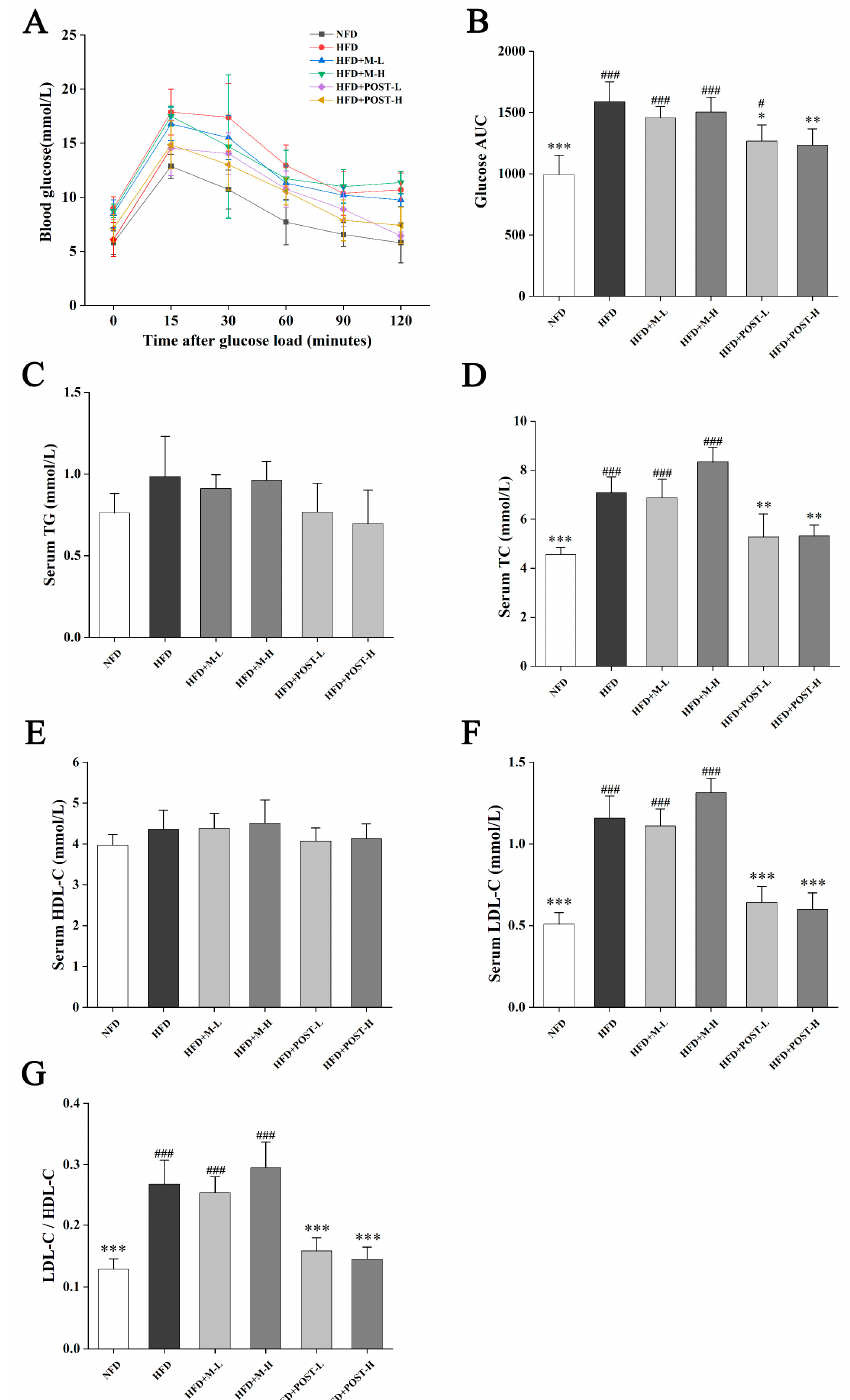
Figure 2. POST improves IR and serum lipid parameters in HFD mice. ( A ) OGTT showed changes in blood glucose at different time points after oral glucose. ( B ) The AUC according to the OGTT curve. ( C – F ) Concentrations of serum lipids indices, namely TG, TC, LDL-C and HDL-C. ( G ) LDL-C/HDL-C value. Compared to HFD, * p < 0.05, ** p < 0.01, and *** p < 0.001; Compared to NFD, # p < 0.05, and ### p <